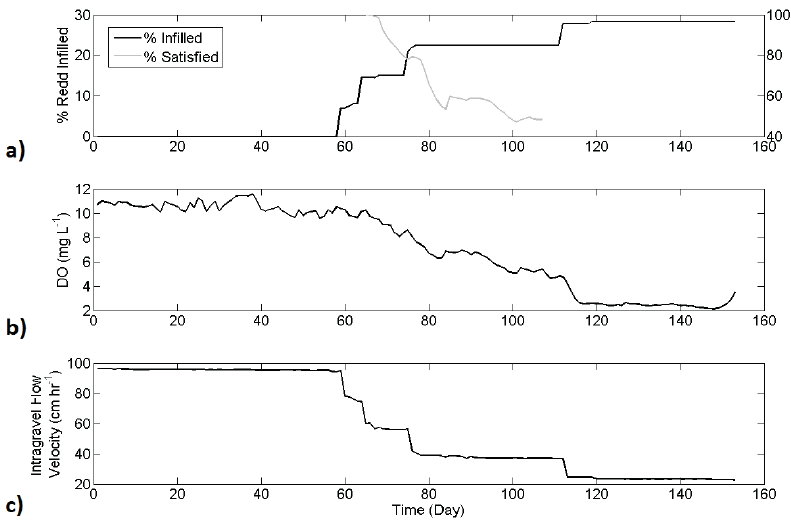
Fig. 4 Baseline SIDO-UK model results for: (a) sediment ingressing/percentage eggs satisfied by oxygen available; (b) DO, and; (c) intra-gravel flow